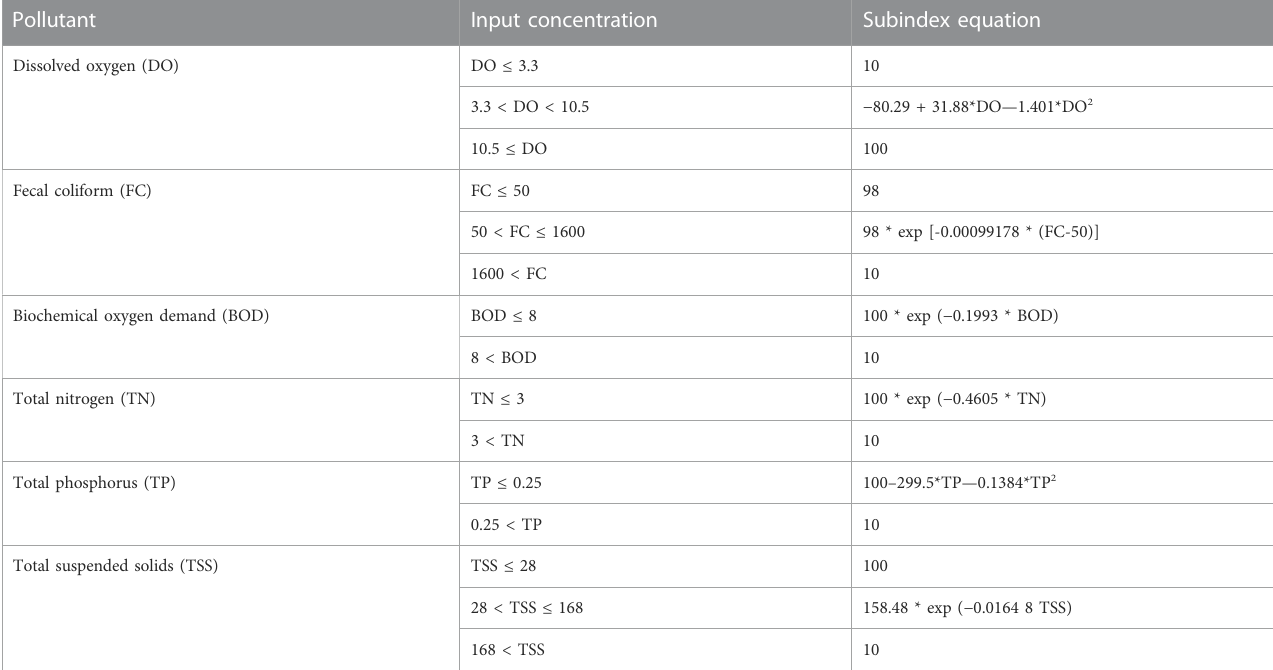
TABLE 4 Water quality index subindex